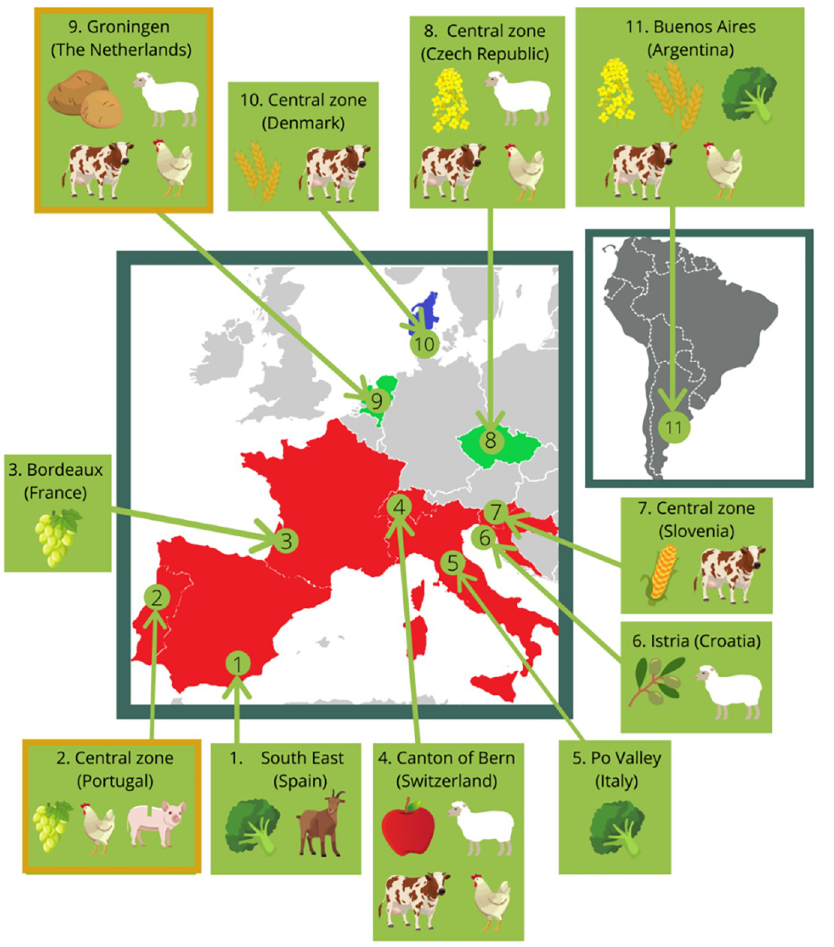
Fig 2. SPRINT Case Study Sites (CSS) location, crops and livestock. Blue on the map = Northern Europe, Green = Central Europe, Red = Southern Europe. Italian and French CSS have no livestock. CSS 2 (Portugal) and CSS 9 (Netherlands) are reference CSS for modelling. At these reference locations, additional water, sediment and air samples will be